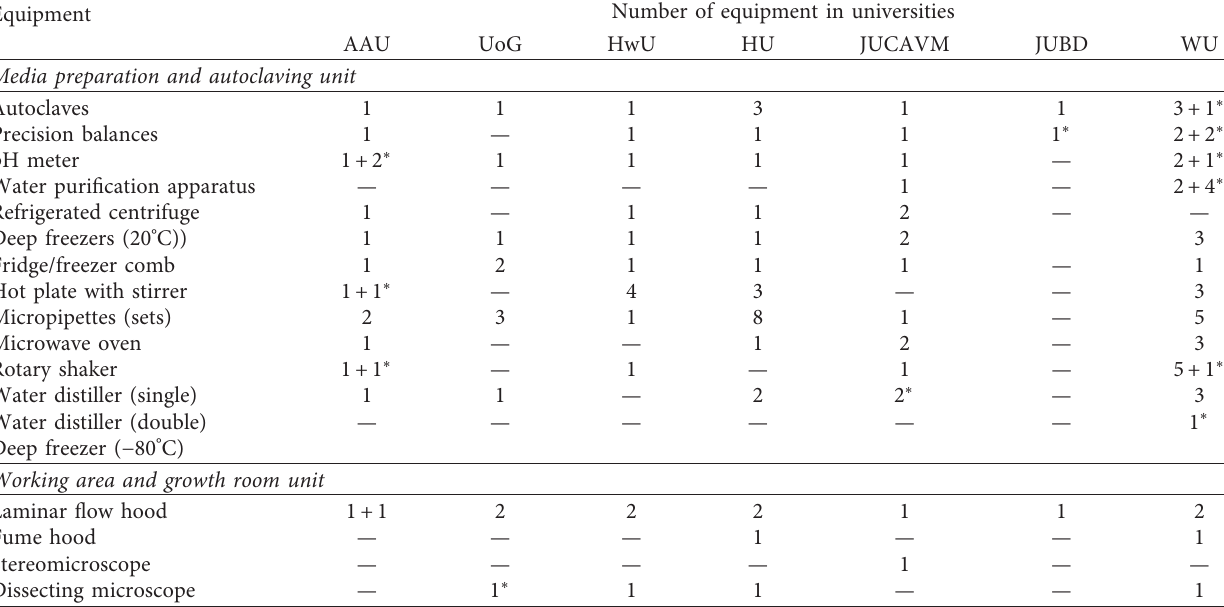
Table 2: List of basic equipment available in PTC laboratories at Ethiopian higher learning institutions.